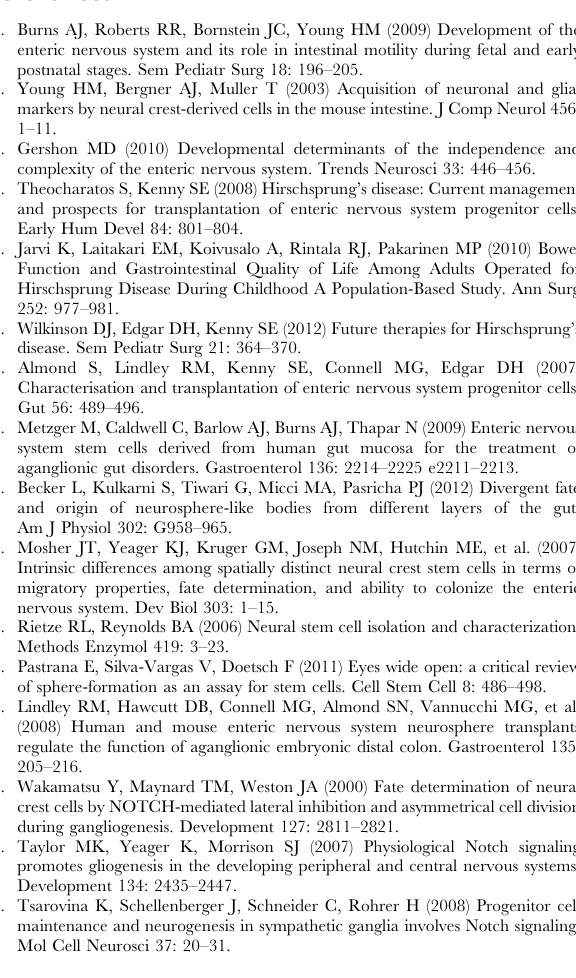
Figure S4 Confirmation of RBPj k knockdown in human neurospheres. Mature 2 nd to 3 rd passage human neurospheres were dissociated and cultured on fibronectin coated chamber slides for 96 h. The dissociated cells were transfected with HsRBPJ_3 siRNA knockdown specific for RBPj k or a corre- sponding negative control. Levels of RBPj k were determined by qPCR. Columns show the normalised D C t values ( 6 SEM, n= 3). *=P ,